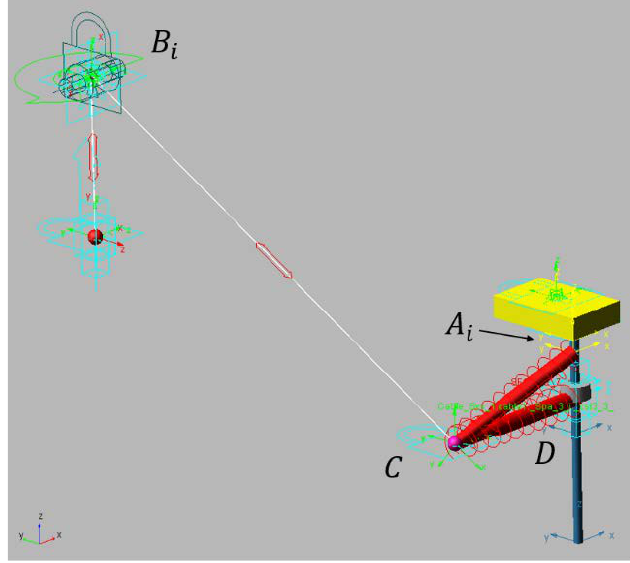
Figure 10. Model of the compliant actuator in the multi-body dynamic simulator MSC ADAMS. Table 1. Pulley parameters.